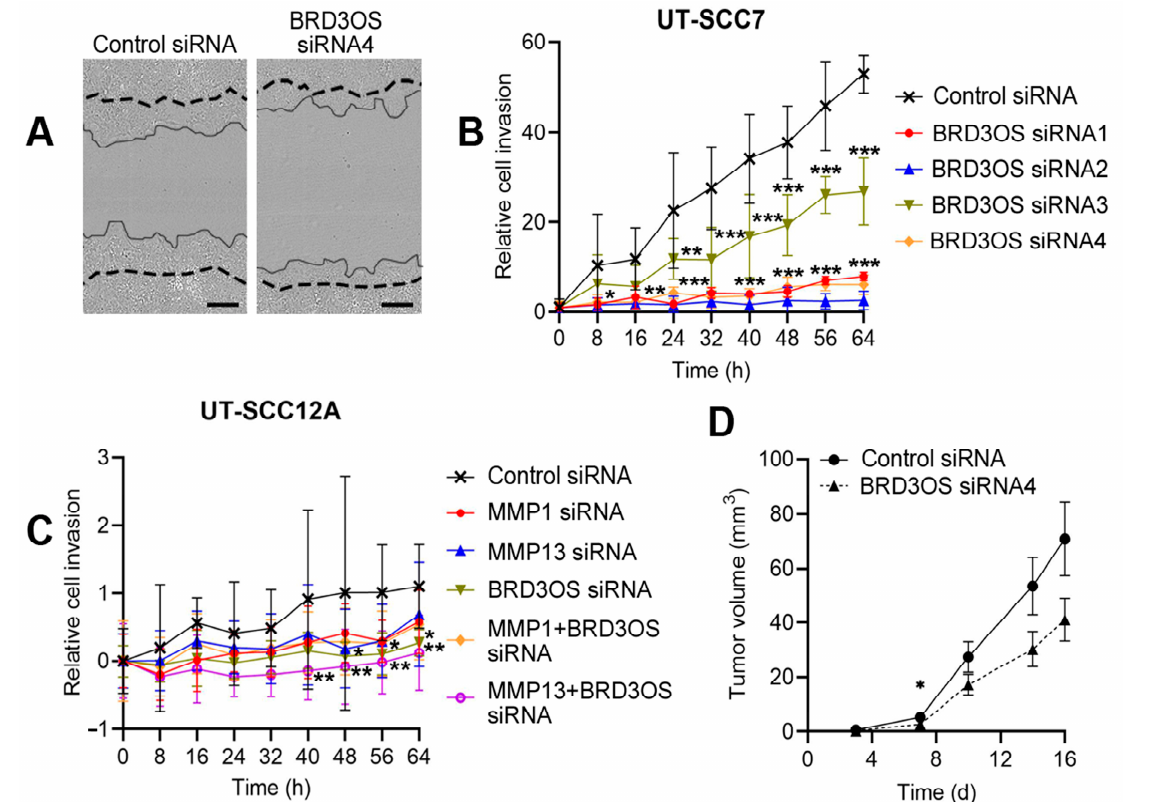
Figure 6. BRD3OS ( LINC00094 ) knockdown inhibits cSCC cell invasion through collagen I. ( A ) Representative images of invasion assay (64 h) of negative control siRNA and BRD3OS siRNA4- treated cSCC cells. ( B ) cSCC cells were transfected with negative control siRNA or four different BRD3OS ( LINC00094 ) siRNAs, or ( C ) with MMP1 and MMP13 siRNAs in combination with or without BRD3OS siRNA siRNA2 and 4 and plated on collagen I 24 h after transfection. Cell monolayer was scratched, and collagen I solution was added in wells and allowed to polymerize, followed by real-time imaging using the IncuCyte S3. Mean ± SD is shown, * p < 0.05, ** p < 0.01, *** p < 0.001, two-way ANOVA, n = 4–7. ( D ) cSCC cells (UT-SCC7) were transfected with negative control siRNA ( n = 8) or BRD3OS siRNA4 ( n = 7) and injected subcutaneously into the back of SCID mice. Tumor growth was measured twice a week. Scale bar = 300 µm. Mean ± SEM is shown. * p < 0.05. Student’s t -test.